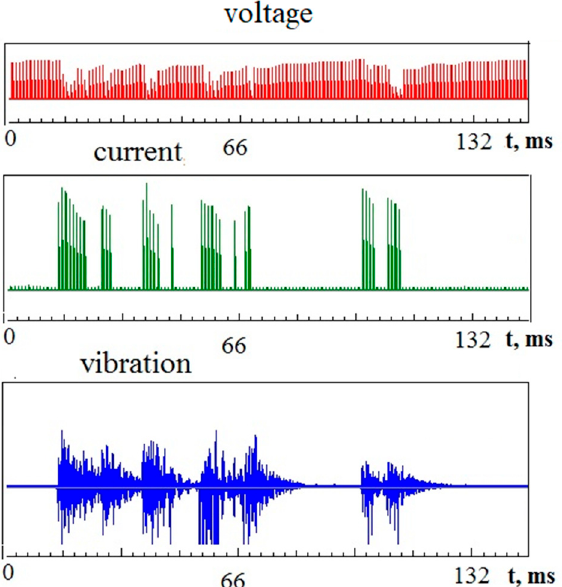
Figure 15. Example of recording voltage, current, and vibration signals during electrical discharge machining with a pulse width of 10% (recording time of 0.3 s).